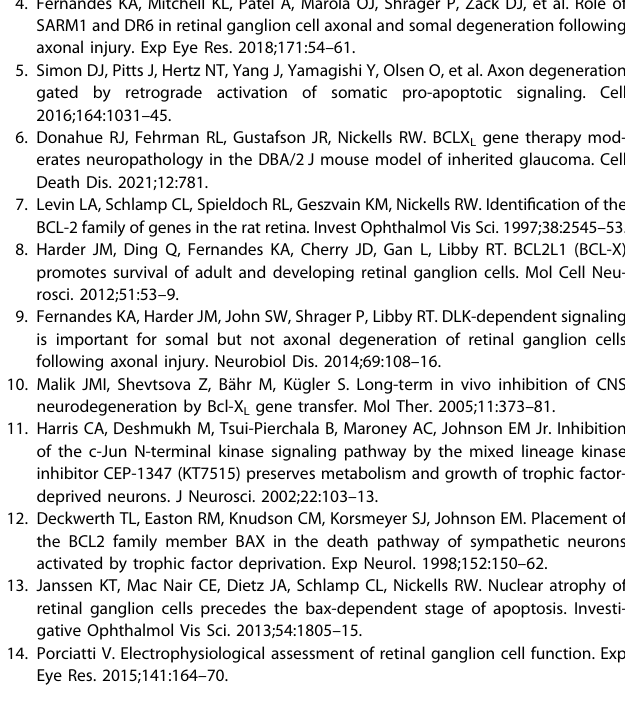
Fig. 1 BclX L overexpression improved RGC somal survival but not axonal degeneration after CONC. A Transduction ef fi ciency of AAV2.2- Pgk-mCherry-BclX L in RGCs as assessed by the percentage of mCherry + (red) RGCs (RBPMS + cells, green) depicted in retinal fl at mounts. On average, 76.1 ± 1.2% of RGCs were colabeled with mCherry. n = 4. Scale bar, 50 µm. B WT ( n = 5) and BclX LAAV ( n = 6) retinal fl at mounts and quanti fi cation of cleaved caspase 3 (cCASP3) + cells 5 days post-CONC. BclX LAAV retinas had 74.9 ± 10.5% fewer cCASP3 + cells compared to WT controls. * P = 0.030, two-tailed t- test. Scale bar, 50 µm. C WT and BclX LAAV retinal fl at mounts and quanti fi cation of RGCs (RBPMS + cells) 14 days post-CONC. Both WT and BclX LAAV retinas had signi fi cant RBPMS + cell loss after CONC compared to Sham controls (85.4 ± 0.8% and 34.8 ± 4.2% loss respectively, * P < 0.001). However, BclX LAAV retinas had 59.2 ± 4.9% improved RGC survival after CONC compared to WT controls (* P < 0.001). n = 5, two-way ANOVA, Holm-Sidak ’ s post hoc test. Scale bar, 50 µm. D Quanti fi cation of RBPMS + RGC soma size from BclX LAAV retinas 14 days after Sham and CONC. After CONC, surviving RGCs from BclX LAAV retinas were 27.5 ± 2.2% smaller compared to Sham controls. n = 5, * P < 0.001, two-tailed t- test. E Representative PERG traces and quanti fi cation of PERG amplitudes from WT and BclX LAAV eyes 14 days post-Sham ( n = 17, 18, respectively) and CONC ( n = 18, 17, respectively). WT and BclX LAAV eyes had signi fi cant reductions in PERG amplitude after CONC relative to Sham (43.5 ± 5.8% and 36.2 ± 6.6% reductions respectively, * P < 0.05). BclX LAAV eyes did not have improved PERG amplitudes after CONC compared to WT controls ( P = 0.816). Two-way ANOVA, Holm-Sidak ’ s post hoc test. Scale bar: X: 100 ms, Y: 5µV. F Longitudinal BclX LAAV optic nerve sections 5 days post-Sham and CONC. Sham BclX LAAV optic nerves had notable axonal mCherry labeling, which was markedly “ beaded ” and lost post-CONC. n = 4. Scale bar, 50 µm. G Longitudinal WT and BclX LAAV optic nerve sections 5 days post-Sham and CONC immunoassayed for neuro fi lament-H. BclX LAAV optic nerves had similar histological signs of degeneration after CONC compared to WT controls. n = 4. Scale bar, 50 µm. H Representative CAP traces and quanti fi cation of CAP amplitudes from WT and BclX LAAV optic nerves 5 days post-Sham and CONC. Both WT and BclX LAAV optic nerves had signi fi cantly decreased CAP amplitudes after CONC compared to Sham controls (59.7 ± 5.6% and 59.3 ± 3.7% amplitude reductions respectively, * P < 0.001). After CONC, BclX LAAV optic nerves did not have improved CAP amplitudes compared to WT controls ( P = 0.582) . n = 5, two-way ANOVA, Holm-Sidak ’ s post hoc test. Scale bar: X: 1 ms, Y: 1 mV. All numerical data are reported as mean ± standard error of the mean. For graphs, bars represent the mean, and error bars represent standard error of the